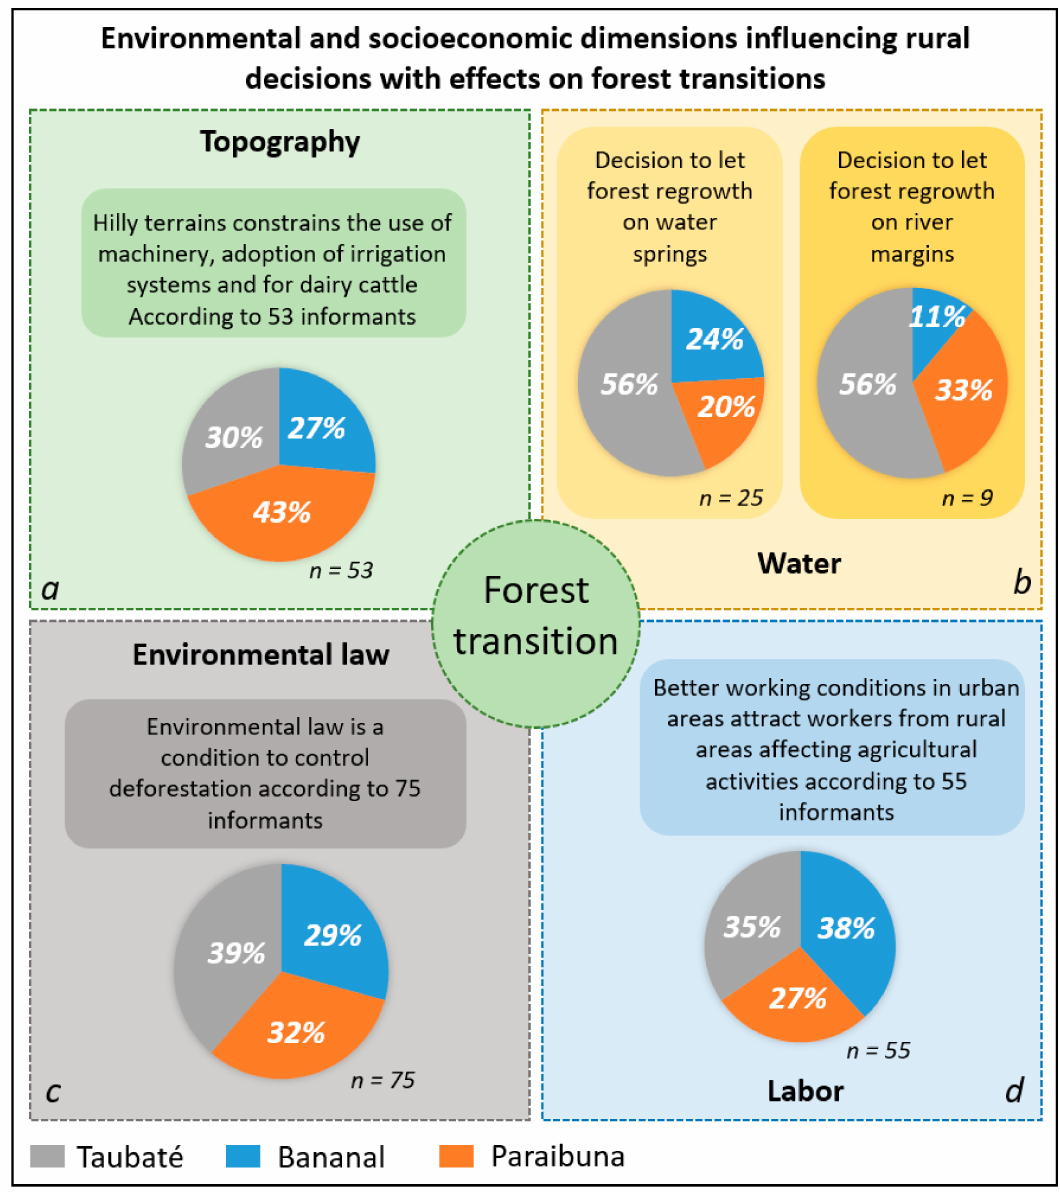
Figure 6. Decisions in rural properties are key to determine regional forest transitions ( n is the number or respondents in each municipality according with variables a , b , c or d